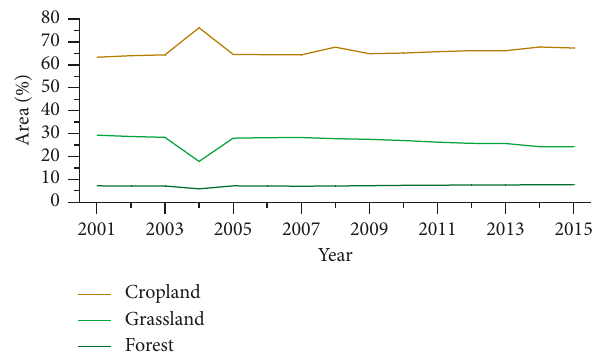
Figure 9: Changes in major vegetation types in the SNP from 2001 to